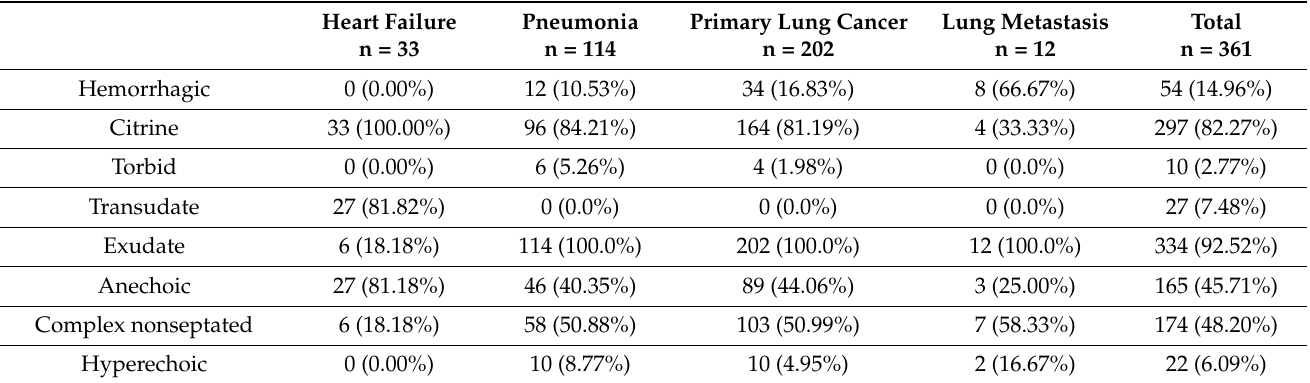
Table 1. Macroscopic, microscopic, and TUS description of the pleural fluid according to the diag- nosed clinical